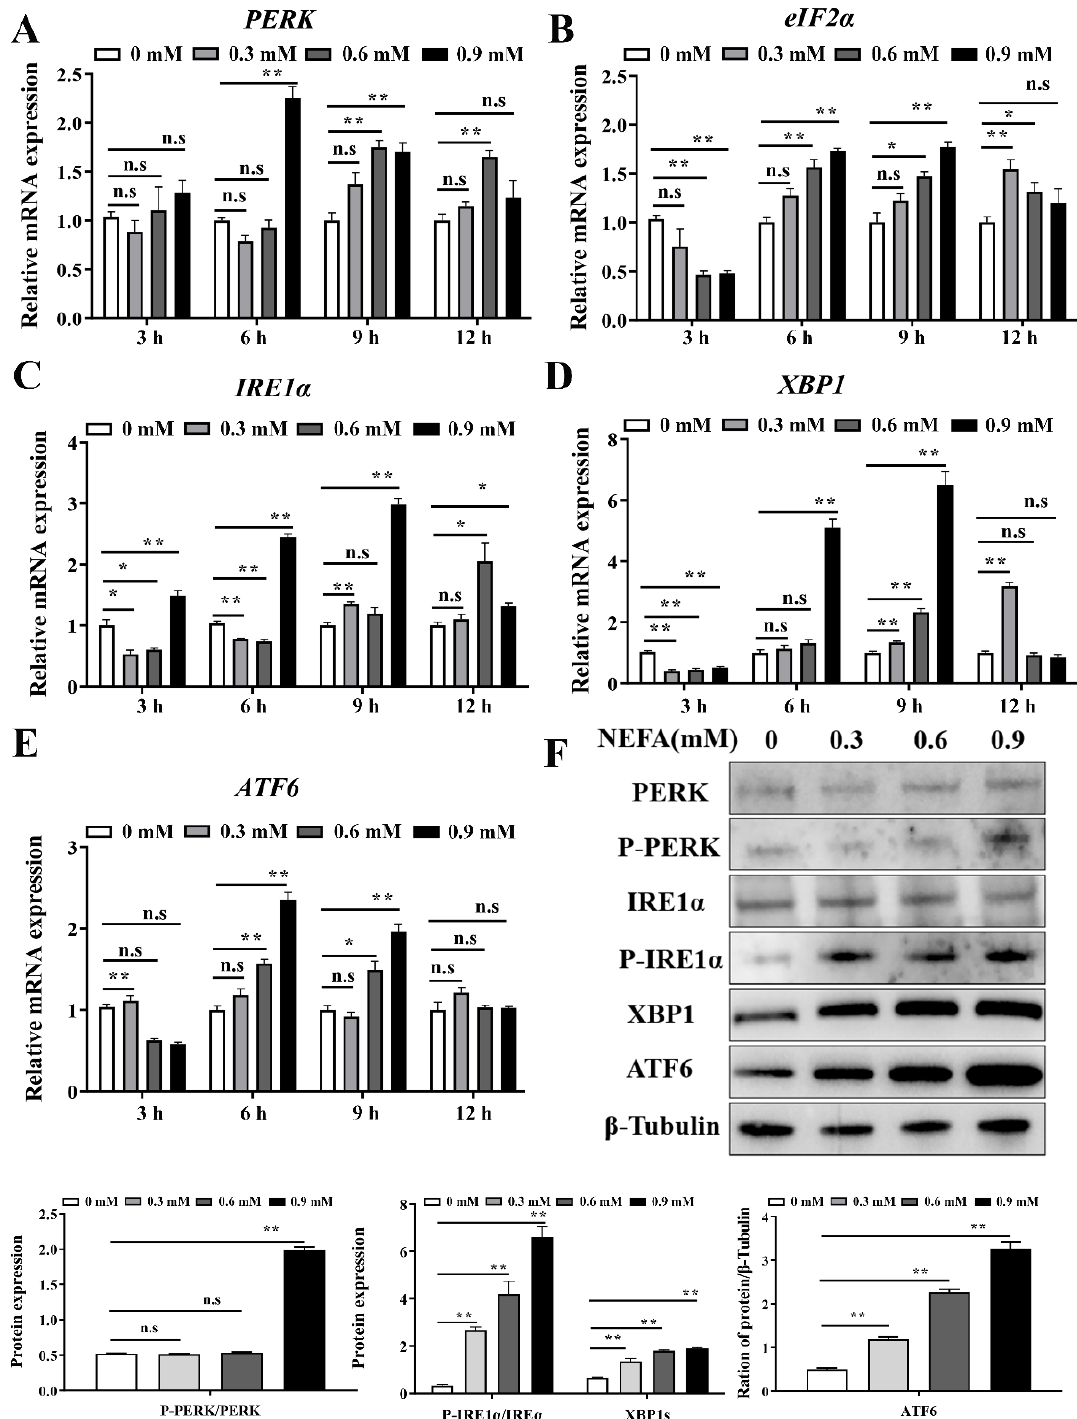
Figure 2. NEFA activated the three UPR signaling pathways in bovine mammary epithelial cells. ( A – E ) Relative mRNA expression of PERK, eIF2α, IRE1α, XBP1, and ATF6 in BMECs after treatment with various concentrations (0.3, 0.6, and 0.9 mM) of NEFA for 3, 6, 9, and 12 h. ( F ) Protein expres- sion of PERK, P- PERK, IRE1α, P - IRE1α, XBP1, and ATF6 in BMECs stimulated with the different concentrations of NEFA for 6 h. Data are presented as the means ± the standard errors of the mean (SEM) of three independent experiments. * p < 0.05; ** p < 0.01.